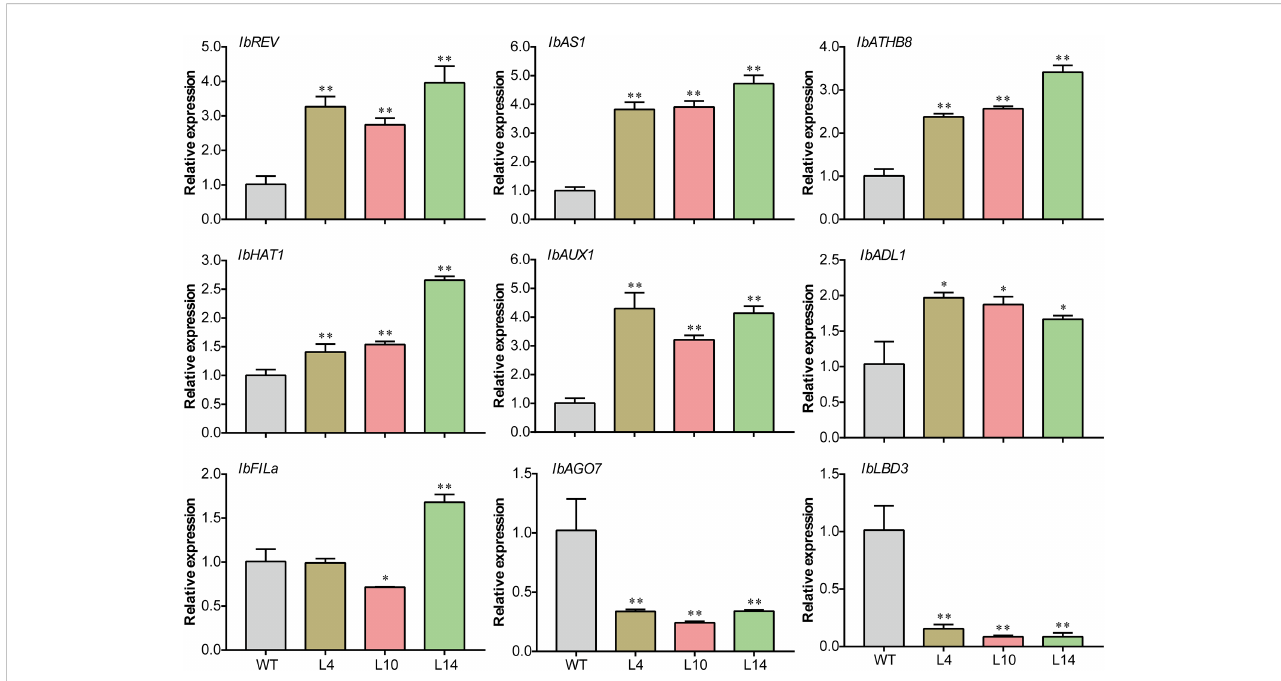
FIGURE 7 Expression of the genes associated with leaf polarity in both IbNAC43 -overexpressed and wild-type (WT) sweet potato plants. Data are presented as the mean ± SE ( n = 3). Asterisks indicate signi fi cant differences compared to the WT based on a Student ’ s t -test. * p < 0.05, ** p <